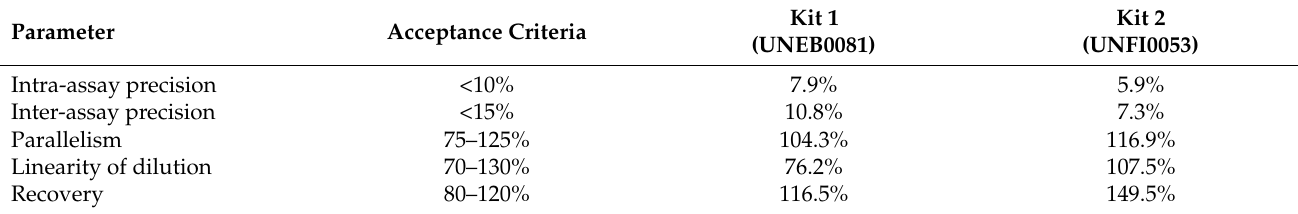
Table 3. Summary of the results of the two validated kits for each parameter in comparison with the acceptance